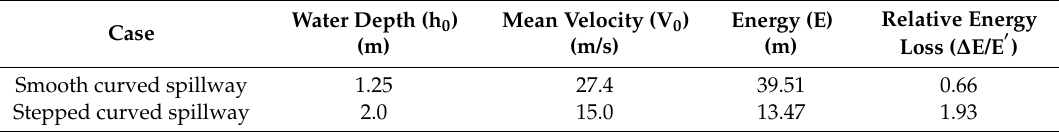
Table 6. Relative energy loss of the curved